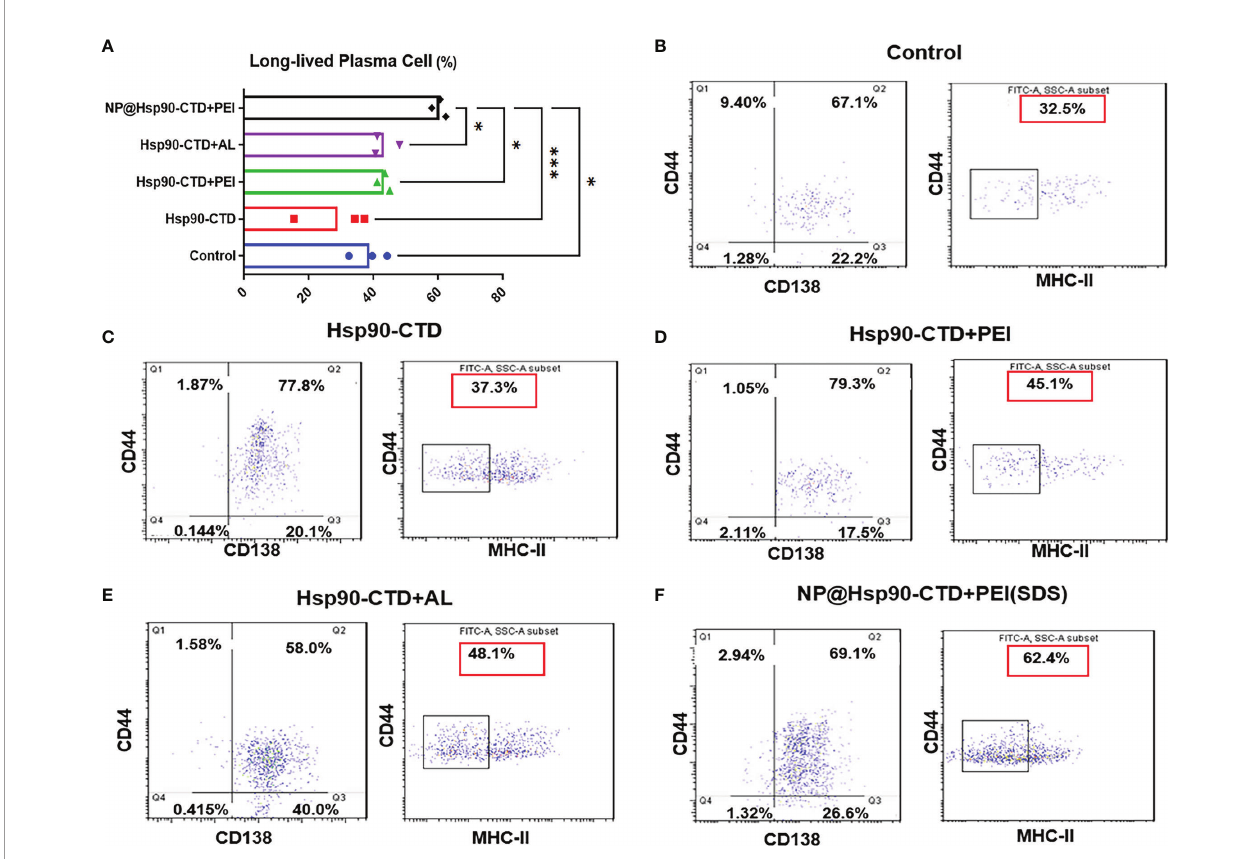
FIGURE 6 | Levels of LLPCs in each group of mice detected by fl ow cytometry. CD44/CD138 gating signify plasma cells, and CD44/MHC II gating signify long-lived plasma cells. 1*104 cells per condition were analyzed by fl ow cytometry. The proportion in the red box represents the proportion of LLPCs. (A) LLPCs of different groups mice. The proportion of LLPCs in the NP@Hsp90-CTD+PEI group was signi fi cantly higher than that in other groups, especially in the Hsp90-CTD group. *P < 0.05; ***P < 0 .001. (B) LLPCs of group control mice. (C) LLPCs of group pure protein mice. (D) LLPCs of group Hsp90-CTD+PEI mice. (E) LLPCs of group Al adjuvants mice. (F) LLPCs of group NP